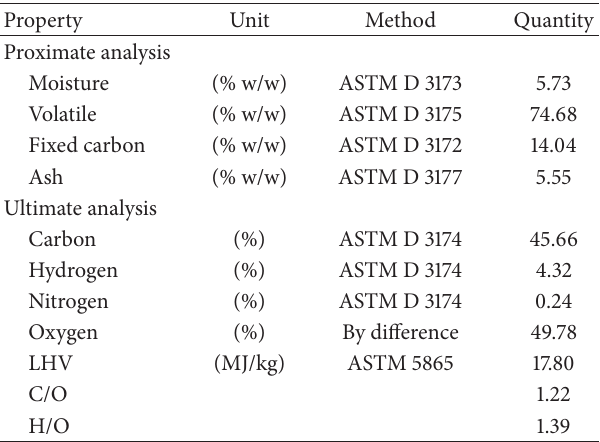
Table 1: Analysis of